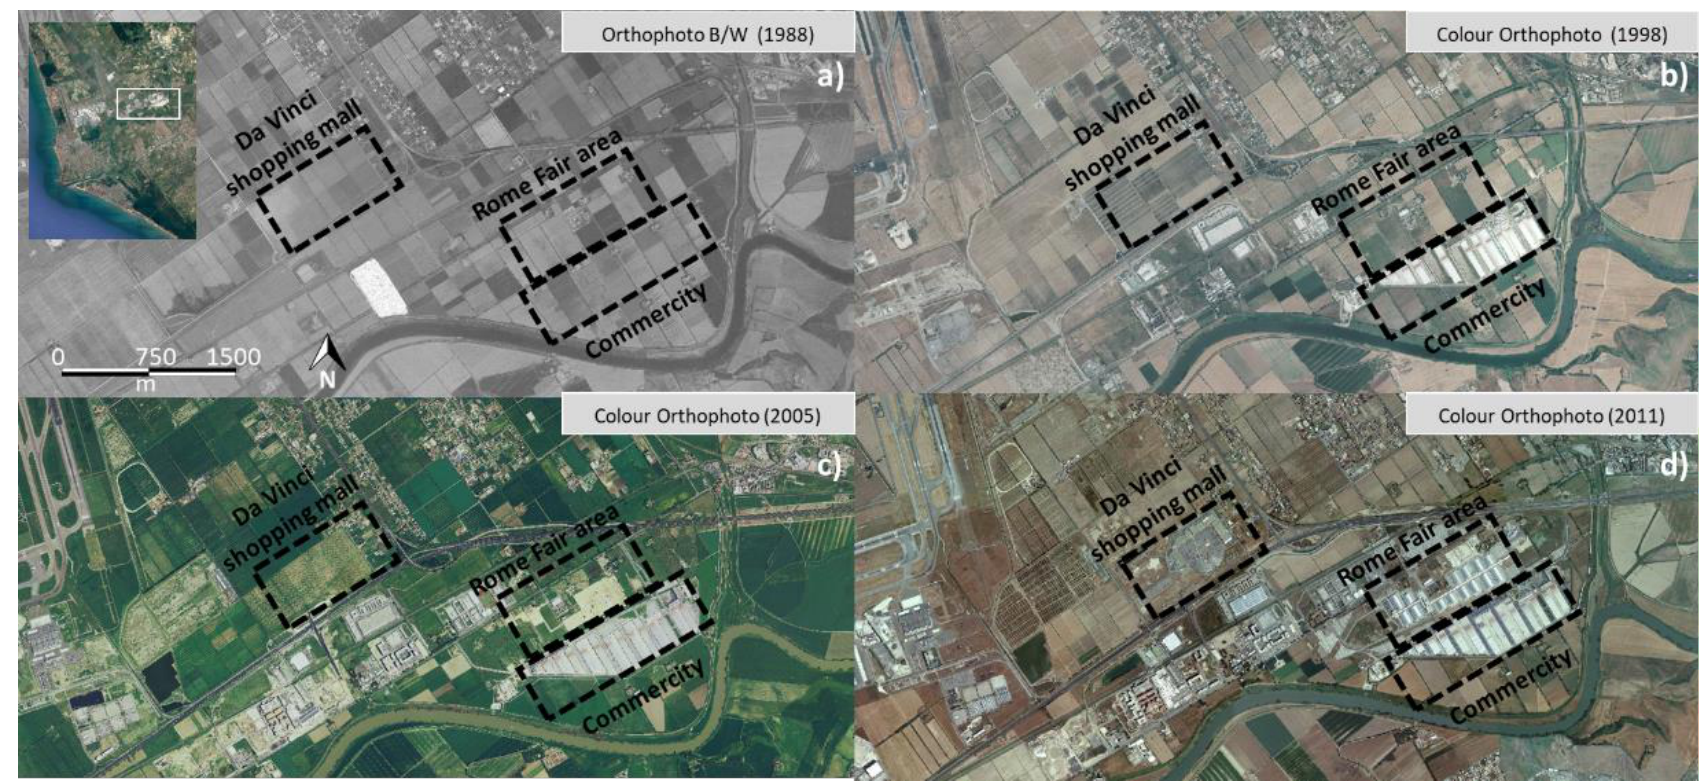
Figure 5 . Multi-temporal view of a representative region showing the intense urbanisation in the time interval 1988 – 2011: ( a ) 1988, ( b ) 1998, (c) 2005, ( d ) 2011. The Da Vinci shopping mall, Commercity, and Rome Fair region are highlighted.